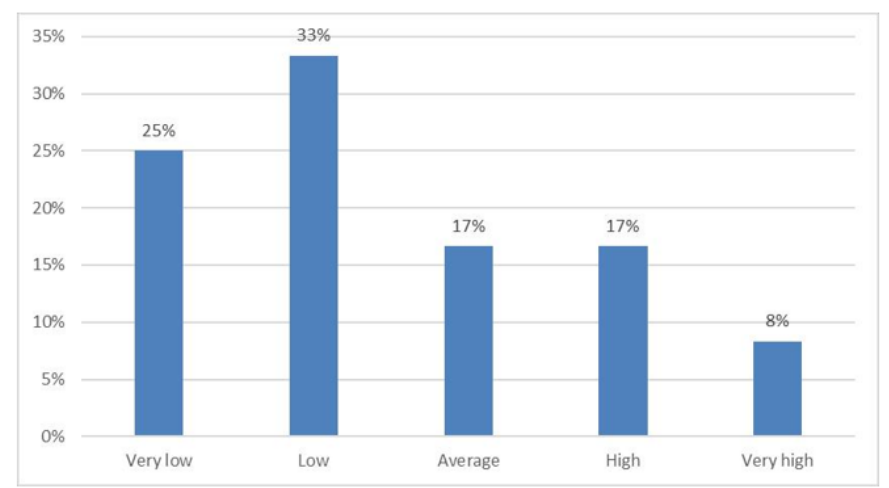
Figure 16. Difficulties in Getting Information and Data about Supply Chain Arrangements (%)